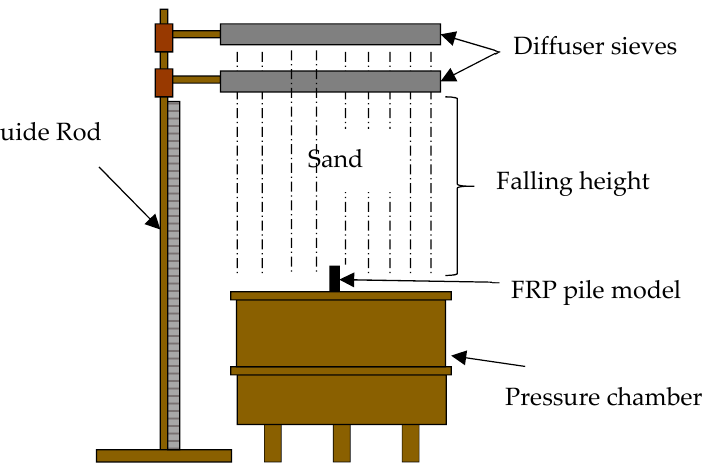
Figure 6. Raining method in order to prepare a uniform distribution of the sand in the cell (not to scale).